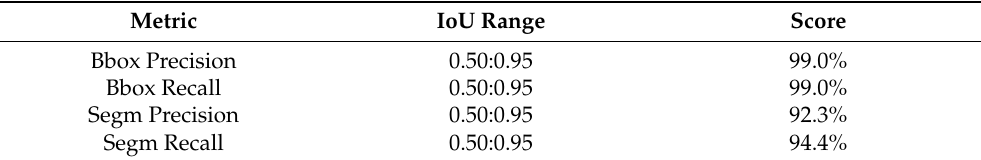
Table 9. leafRCNN performance upon the IFL testing